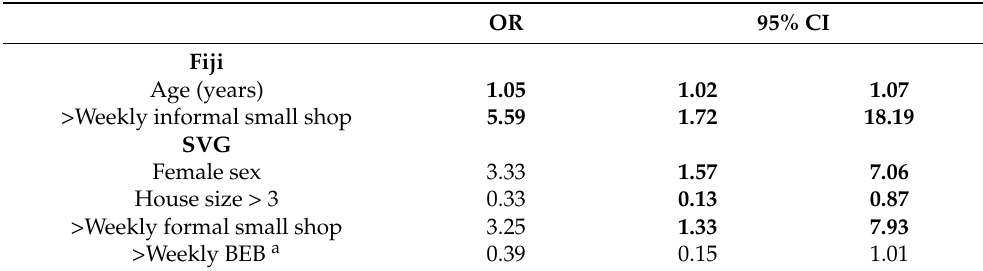
Table 5. Statistically independent socio-demographic and food source predictors of food insecurity in Fiji and SVG.